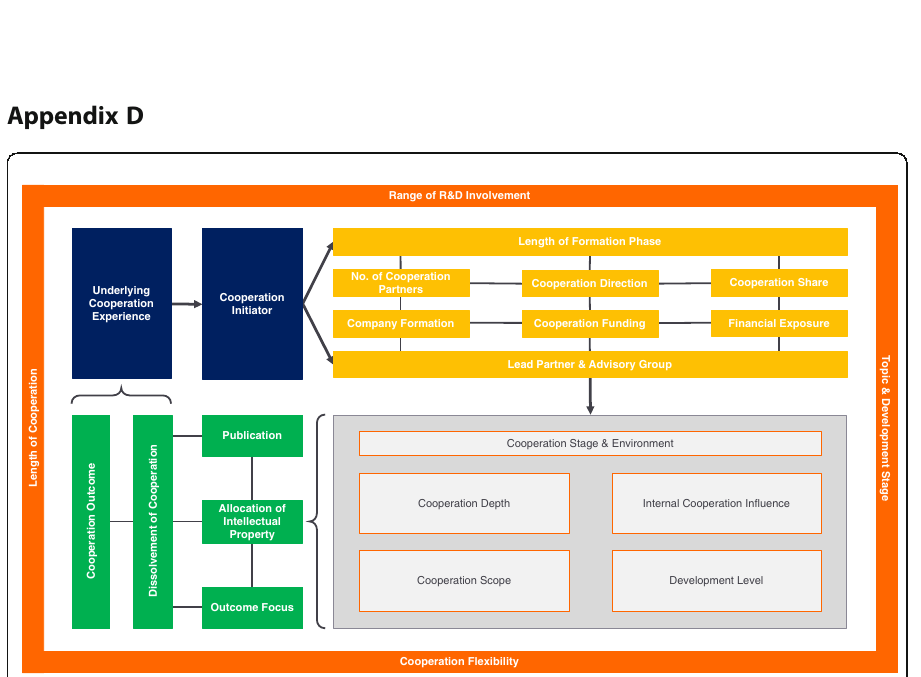
Fig. 7 External Stakeholders and Potential Cooperation Partners. Source: Own Illustration